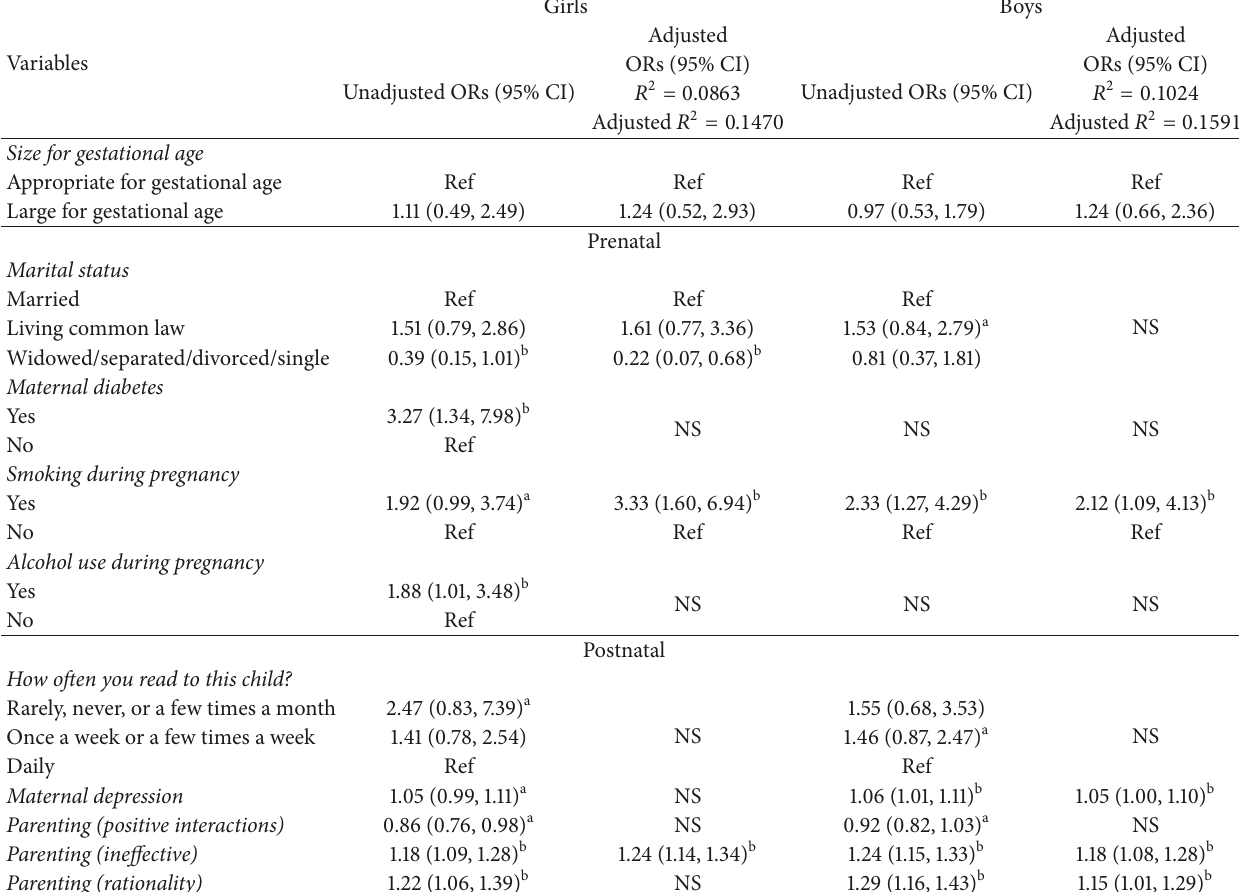
Table 3: Unadjusted and adjusted odds ratios (95% CI) for externalizing behaviour problems in girls and boys aged 4-5